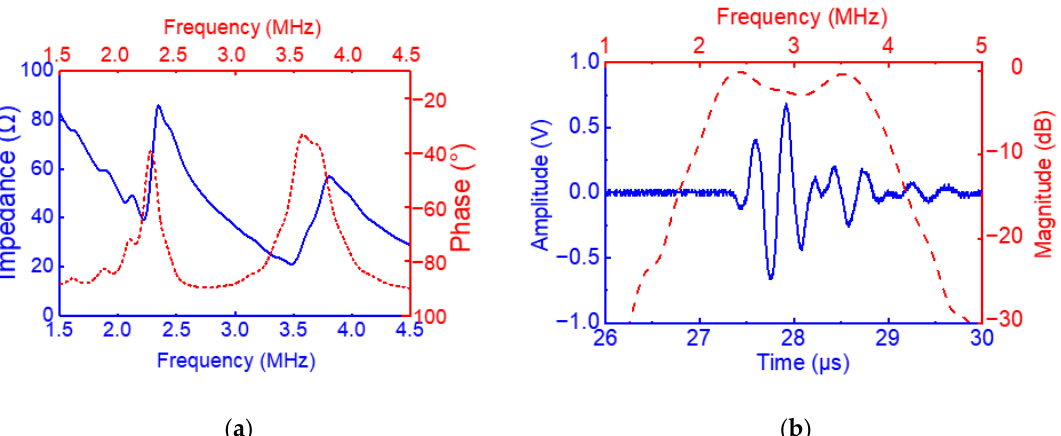
Figure 9. ( a ) Measured electrical magnitude and phase angle; ( b ) pulse-echo wave and frequency spectrum performances of the transducers.